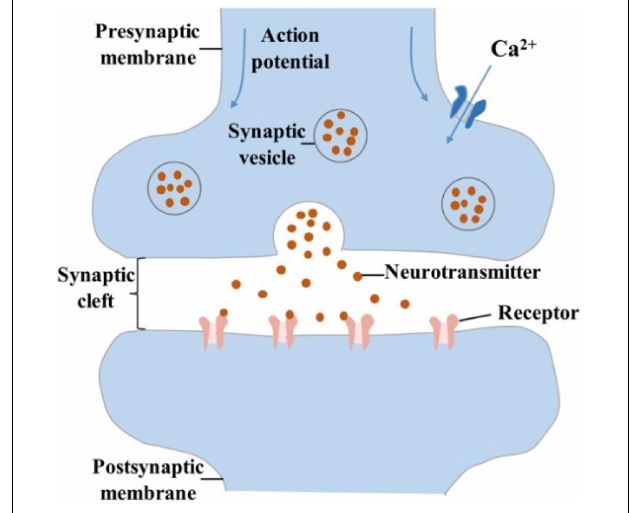
FIGURE 2 | Schematic diagram of chemical synapse, that is composed of presynaptic membrane, synaptic cleft, and postsynaptic